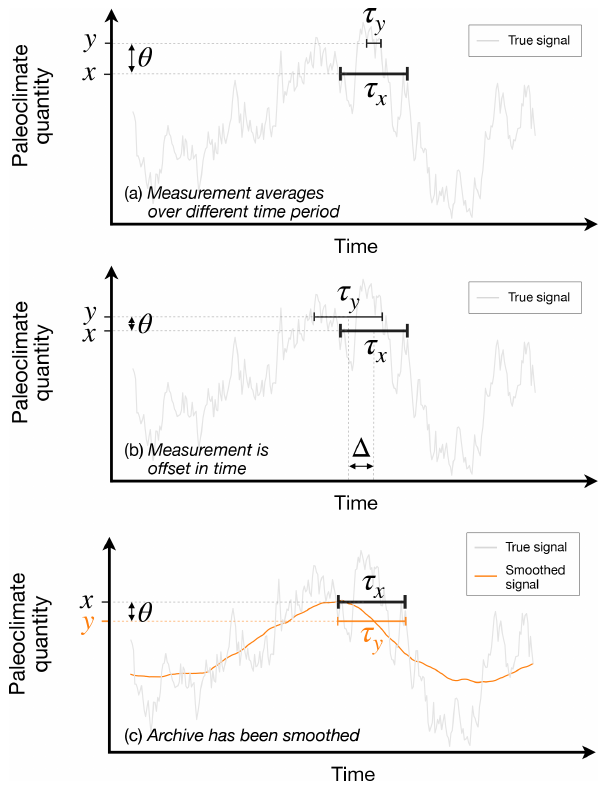
Figure 1. Several factors can contribute to temporal representative- ness errors, defined here as the difference θ between a true time- average paleoclimate quantity x and a measurement y that averages over a different time interval. These effects are illustrated using a synthetic autoregressive time series. In each panel, the true quantity x is the same. Panel (a) shows the difference when y averages over a time duration τ y that is 5 times shorter than the averaging interval τ x of the target value. Panel (b) shows the error when the observed and target averaging intervals are the same, but the observation is centered on a different value in time. Additional uncertainties, not shown here but discussed in the text, arise if the time offset is a stochastic random variable, as can occur, e.g., with chronological uncertainties from radiocarbon dating. Panel (c) illustrates effects when the observation spans the correct time interval but when the paleoclimate archive being sampled stores a smoothed version of the true signal; here that smoothing has a timescale of τ a = 2 τ x . These errors are merely examples and are not meant to argue, e.g., that offset errors are always greater than errors from different aver- aging